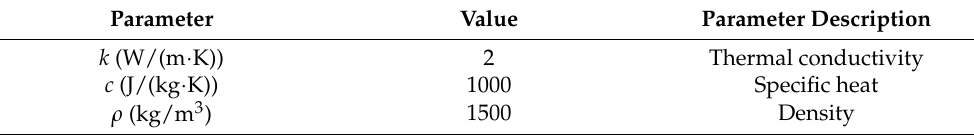
Table 5. Material thermal properties of the structure.